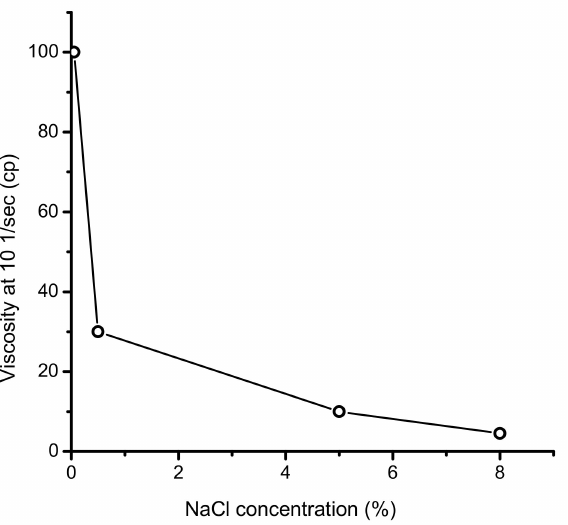
Figure 1. Viscosity of 1.1 × 10 − 7 mol/kg of Pusher 1000, a commercial HPAM solution, at 28.5 ◦ C, adapted from Samanta et al.